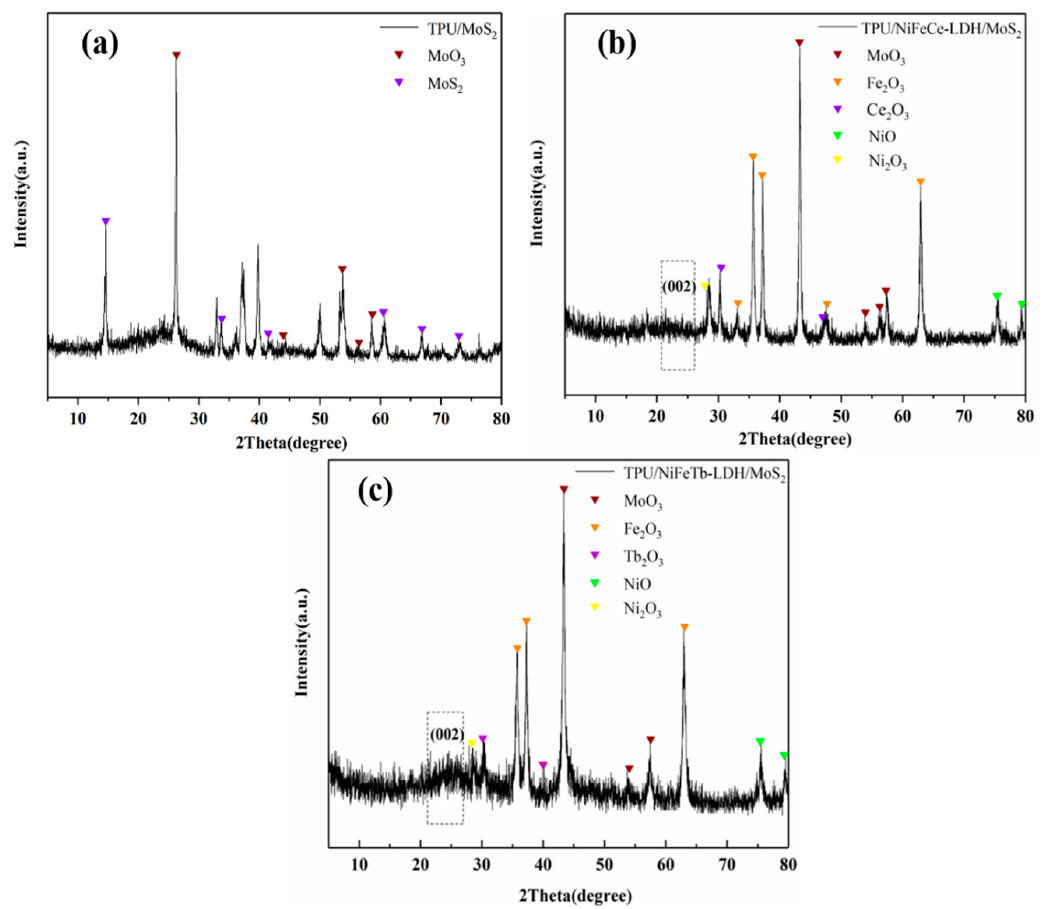
Figure 12. XRD patterns of carbon residues of TPU/MoS 2 ( a ), TPU/NiFeCe-LDH/MoS 2 ( b ) and TPU/NiFeTb-LDH/MoS 2 ( c ). TPU/NiFeTb-LDH/MoS 2 ( c